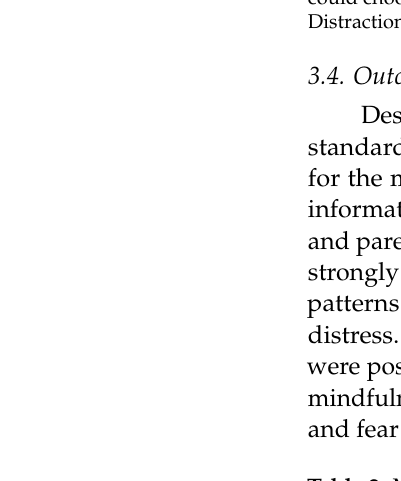
Table 2. Means, standard deviations, and correlations with confidence intervals for RCT outcomes for the mindfulness group (top) and control group